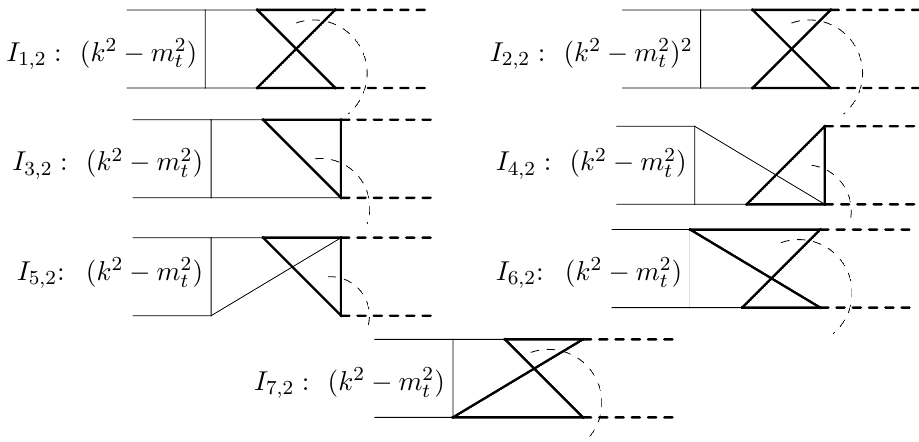
Figure 6. Integrals appearing in (4.12). I 1 , 2 is the corner integral of the topology under consid- eration. I is a second integral in the topology, but with an extra numerator ( k 2 − m 2 2 , 2 is equal to the difference of the momenta of the edges marked by the thin dashed lines. Integrals I 3 , 2 , I 4 , 2 , I 5 , 2 , I 6 , 2 , I 7 , 2 belong to subtopologies. All integrals are defined in d = 4 − 2 (cid:15)